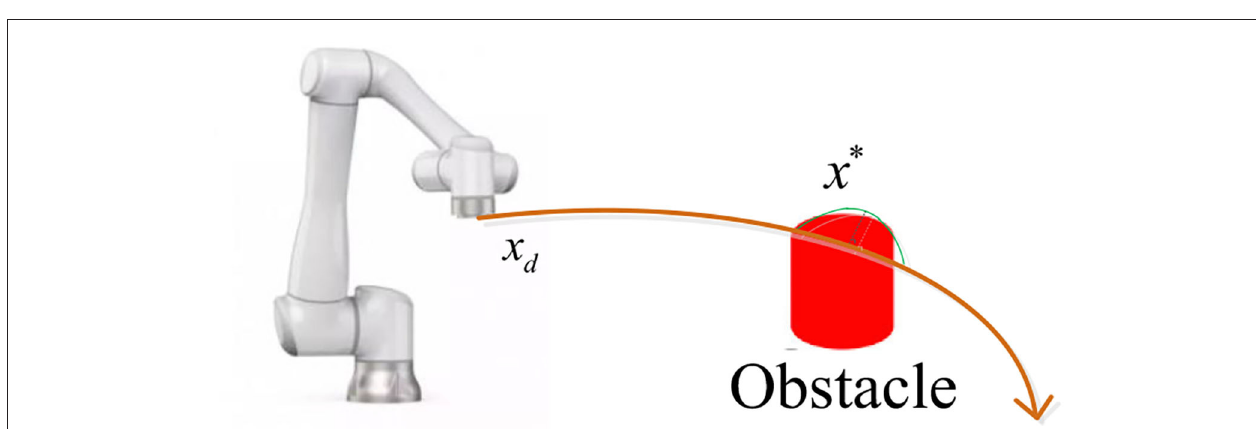
FIGURE 3 | Processing of three-dimensional (3D) point cloud.